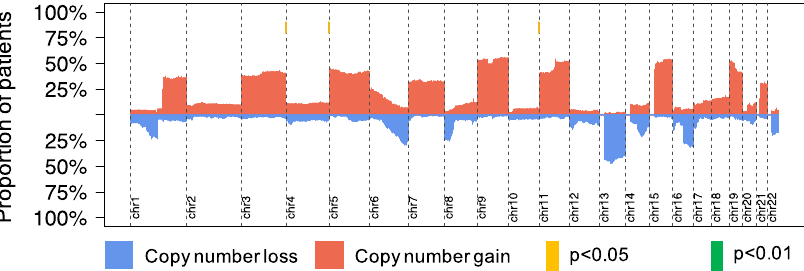
Fig. 4 Copy number pro fi le of myeloma precursor condition and multiple myeloma (MM). Cumulative copy number pro fi le of all patients with either WGS or SNP array data available. Cases were grouped according to their clinical stage: stable ( N = 81) and progressive ( N = 19) myeloma precursor condition and MM ( N = 228). Red and blue bars re fl ect chromosomal gain and loss, respectively. Yellow and green lines on the top of each graph represent GISTIC peaks with a signi fi cantly different prevalence across the three stages (yellow: Fisher ’ s exact test p < 0.05 and green: q < 0.1). On the fi rst, second and third cumulative plots we reported the signi fi cant difference between: stable myeloma precursor condition vs. MM, stable myeloma precursor condition vs. progressive myeloma precursor condition and progressive myeloma precursor condition vs. MM, respectively. MGUS: